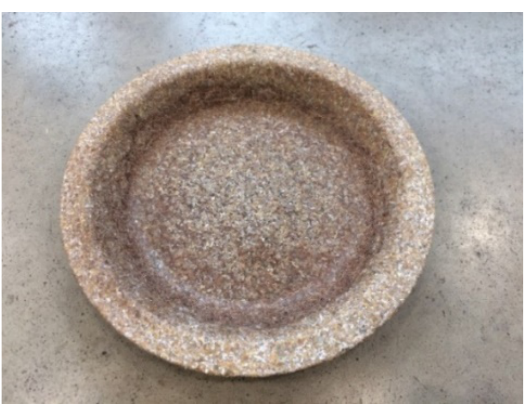
Fig. 6. Prototype of a plate made from rye